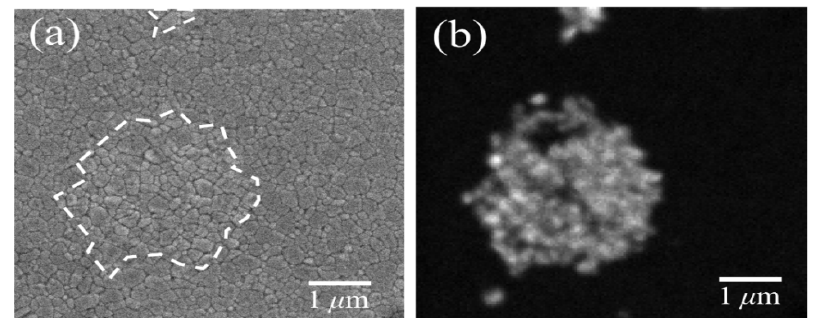
Figure 11. In ( a ) and ( b ), a scanning electron micrograph and a CL intensity maps at 390 nm, respectively, as recorded at the same site on the surface of 3Y-TZP Sample